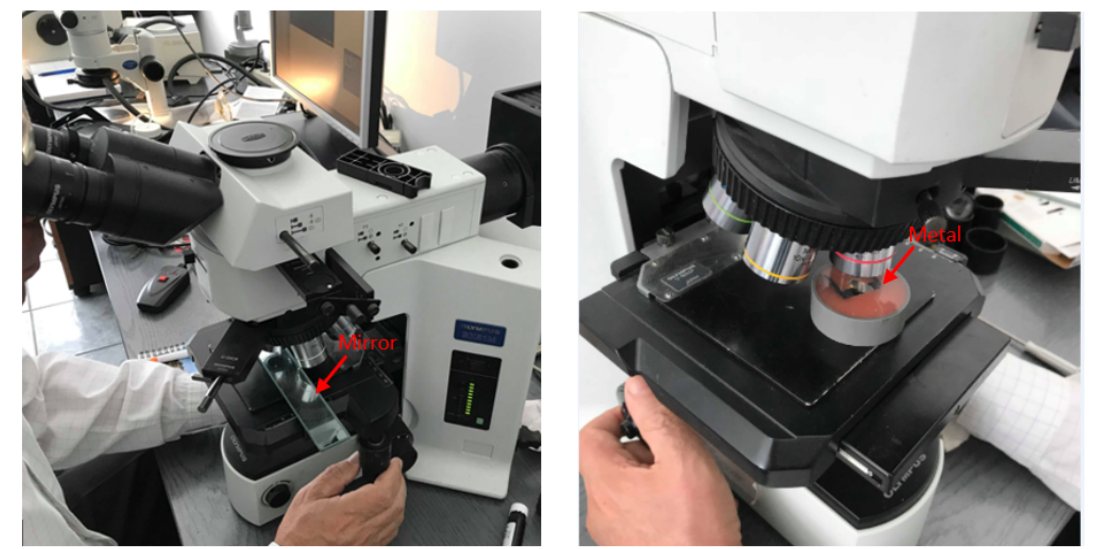
Figure 3. Fog particles analysis using Olympus BX51M microscope: on mirror ( left ) and on metal ( right